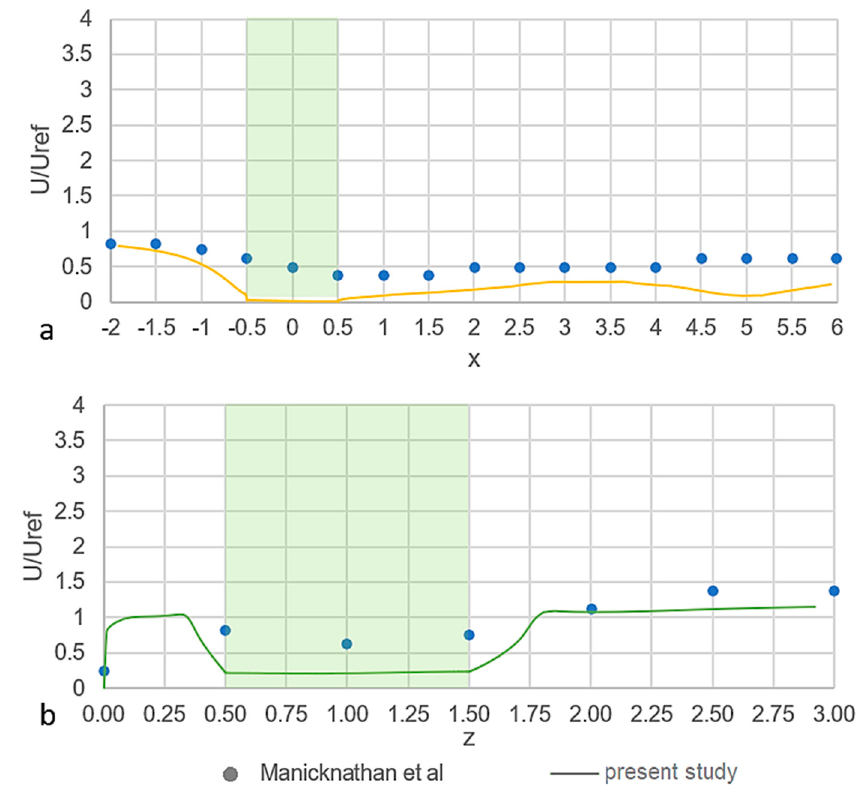
Figure 7. ( a ) Wind speed along the direction of the inlet; ( b ) wind speed across the inlet direction; location of vegetation is shown in green in both cases.